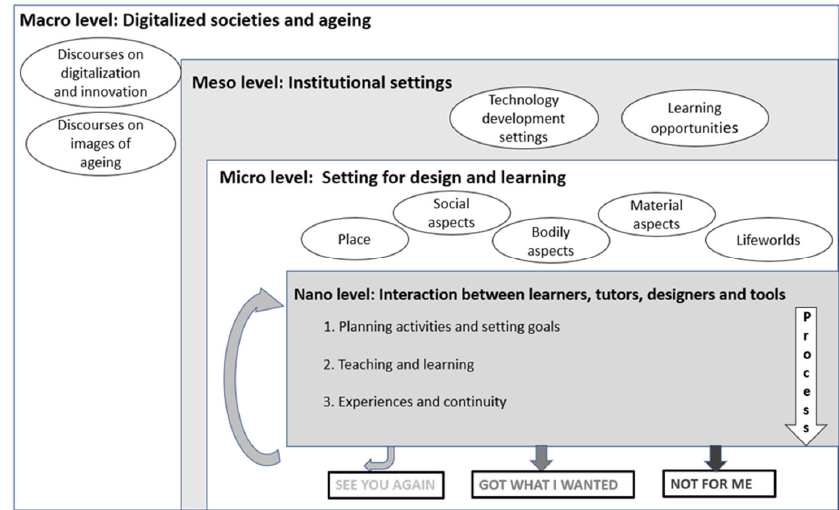
Figure 1. A multilevel model of parameters influencing older adults’ appropriation of ICT and acquisition of digital literacy.